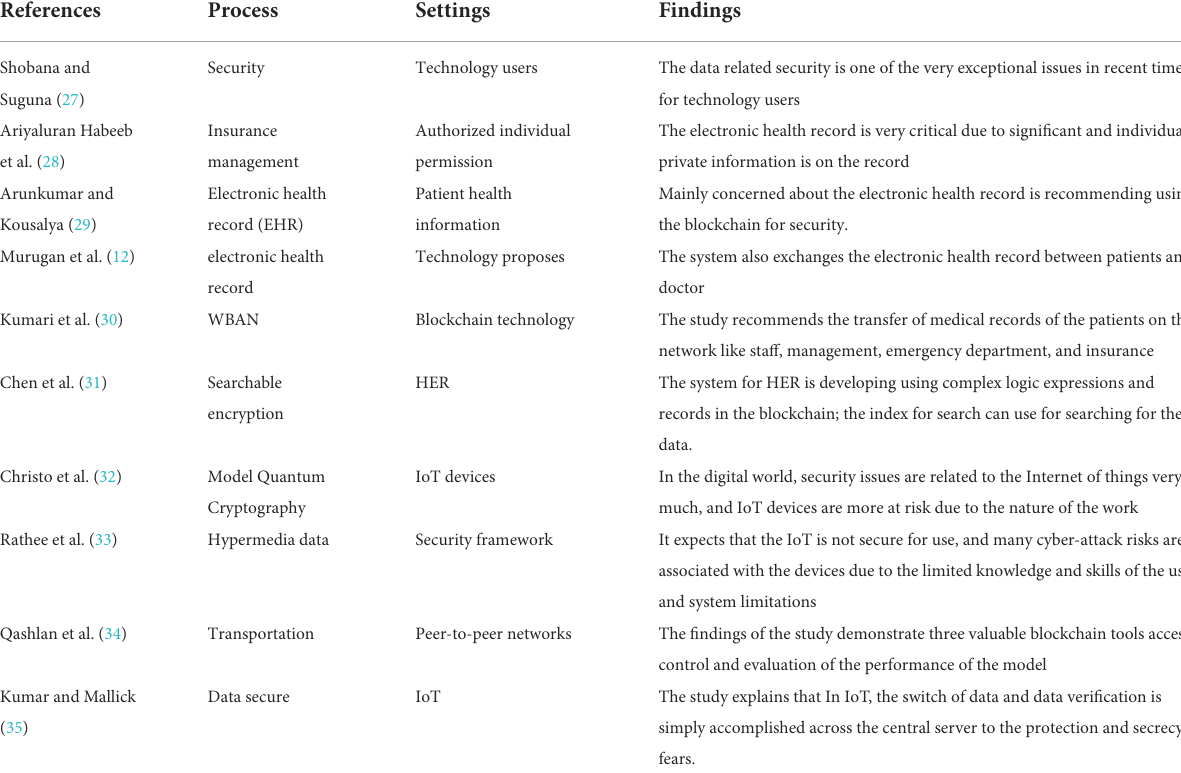
TABLE 4 Blockchain research in